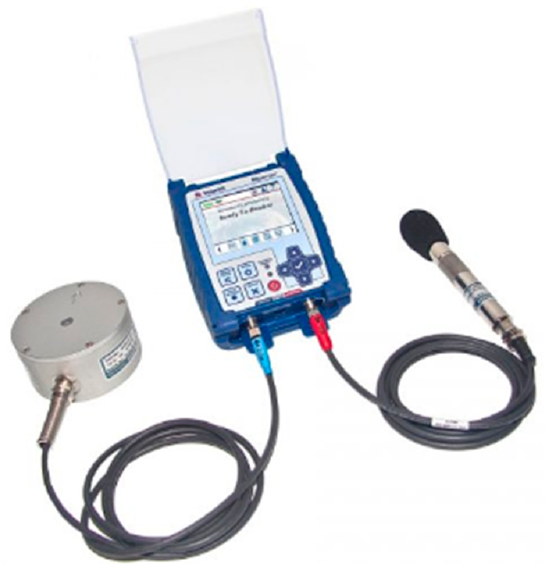
Figure 3. Instantel Micromate ISEE Std/XM seismograph.